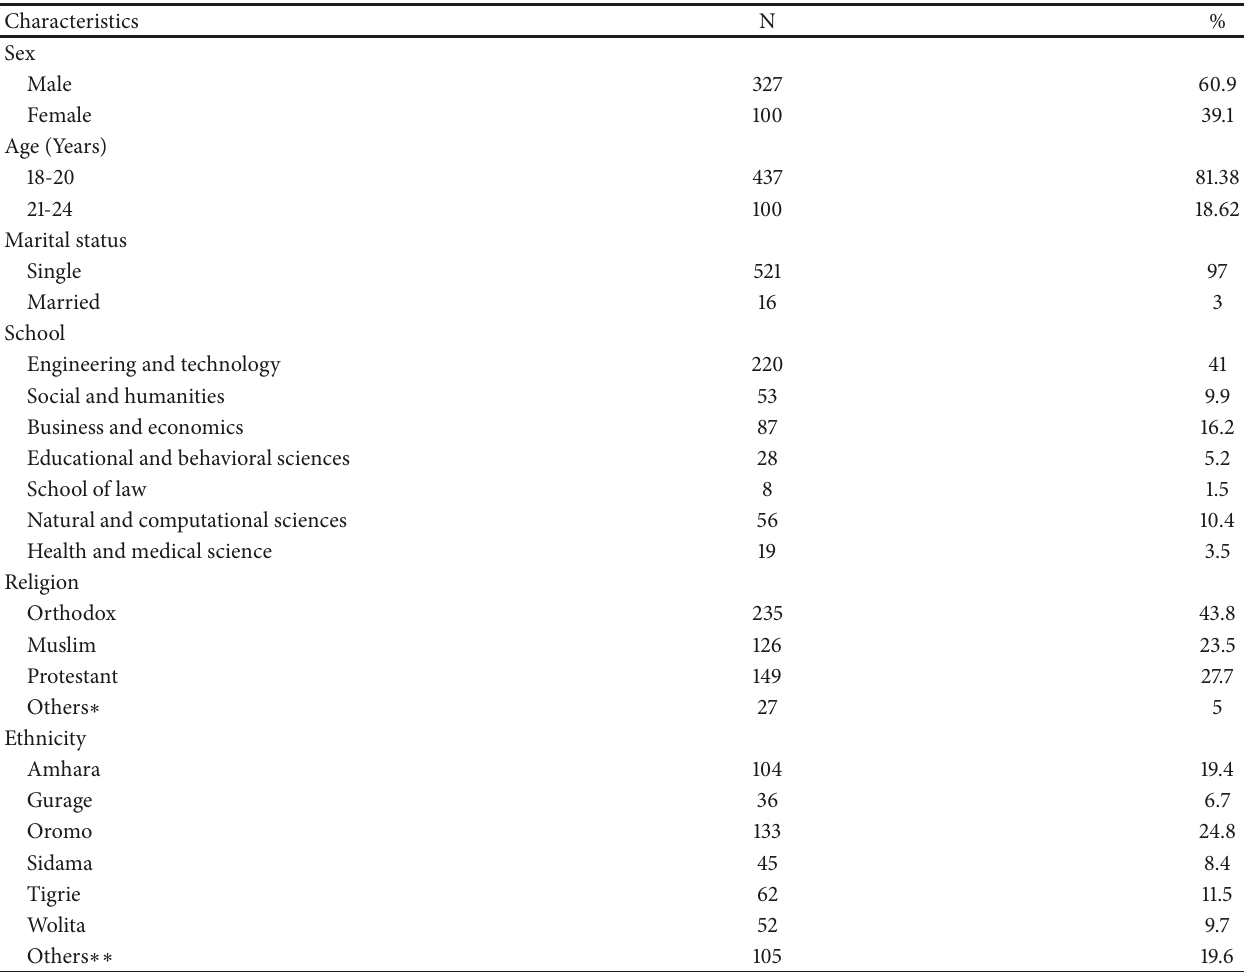
Table 1: Distribution of freshman students at Dilla university, Dilla, Southern Ethiopia, 2016 (N=537).